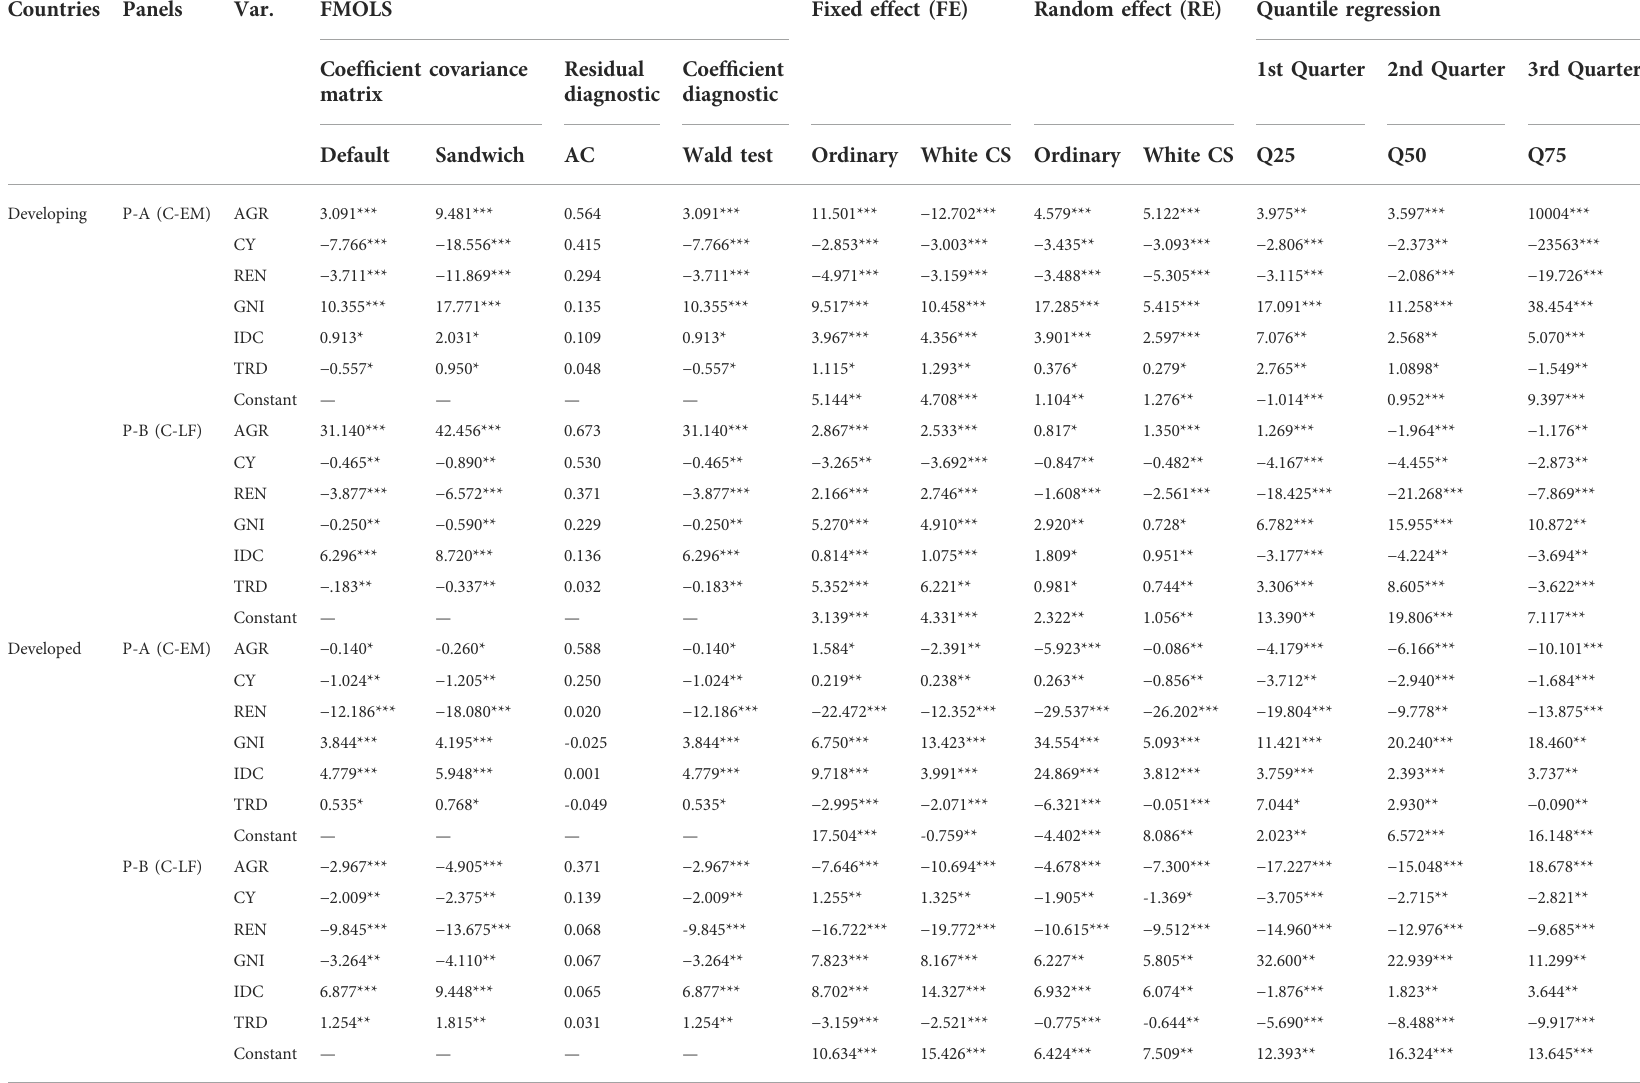
TABLE 5 FMOLS, RE, Random Effect; FE, Fixed Effect, Quantile regression of developing and developed countries. Countries Panels